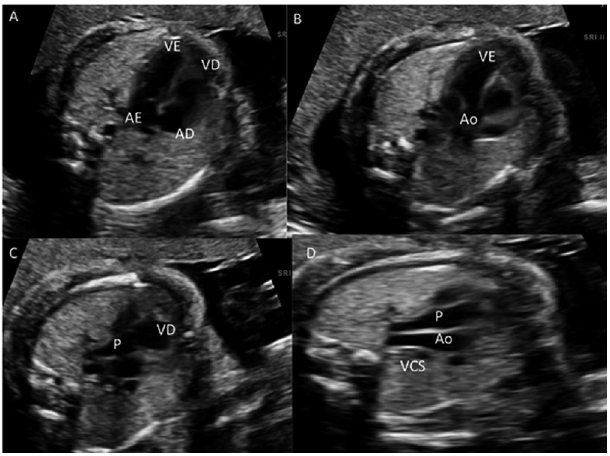
Fig. 1 - Images for evaluating the fetal cardiac screening by two- dimensional ultrasound. A: four-chamber view of the fetal heart. B: left ventricular outflow tract (LVOT). C: right ventricular outflow tract (RVOT). D: three-vessel view of the fetal heart. LV: left ventricle. RV: right ventricle. LA: left atrium. RA: right atrium. P: pulmonary artery. Ao: aorta. SVC: superior vena